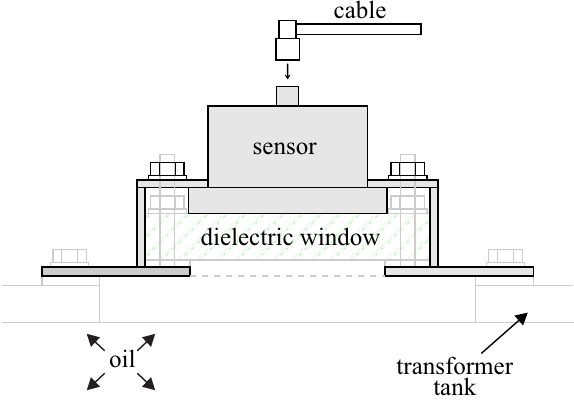
Figure 2. UHF sensor and window assembly on a transformer hatch cover